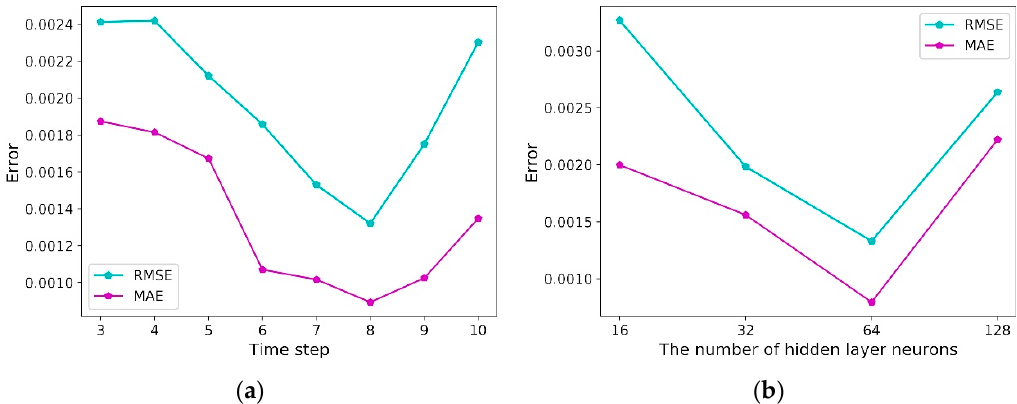
Figure 9. ( a ) Error variation with time step. ( b ) Error variation with the number of hidden layer neurons. The blue line represents RMSE variation, and the purple line represents MAE variation.